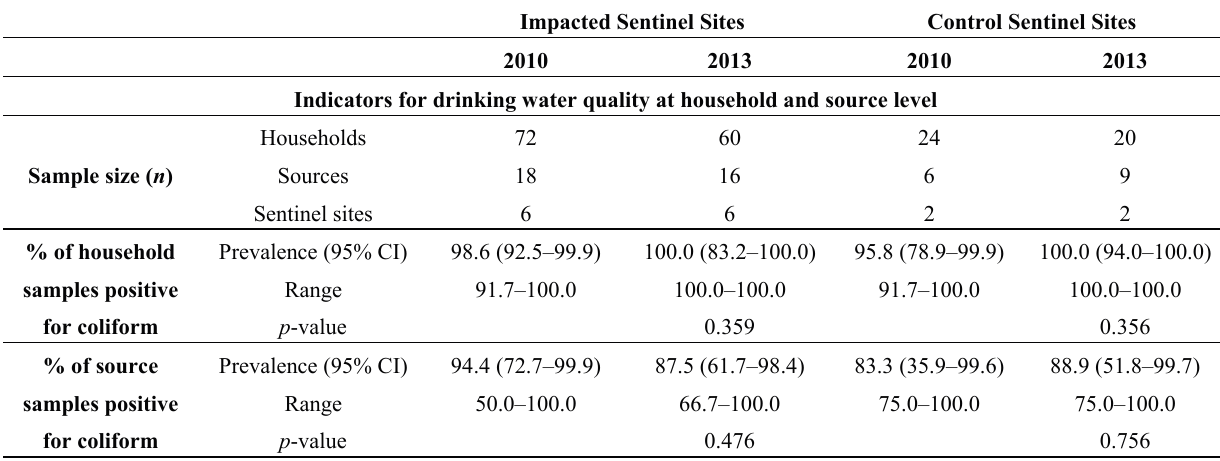
Table 4. Percentage of drinking water samples at the household and source level positive for coliform, in the ABSL study area, 2010 and